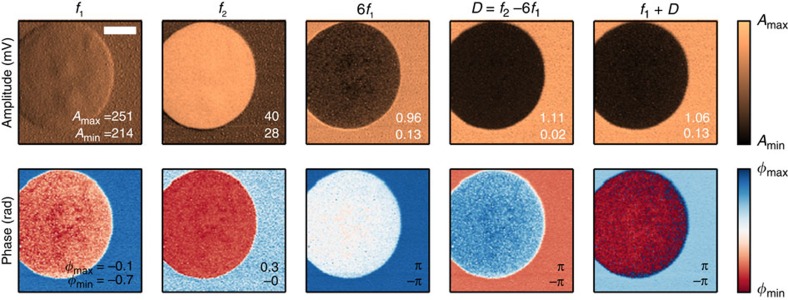
Subset of amplitude and phase images of PS –LDPE.White scale bar is 500 nm, total scan size was 2 μm × 2 μm. Numbers in bottom right corners show the limits of the colour scales Amax, Amin and ømax, ømin for each amplitude and phase image respectively. See Supplementary Table I for amplitude ratios between PS and LDPE.